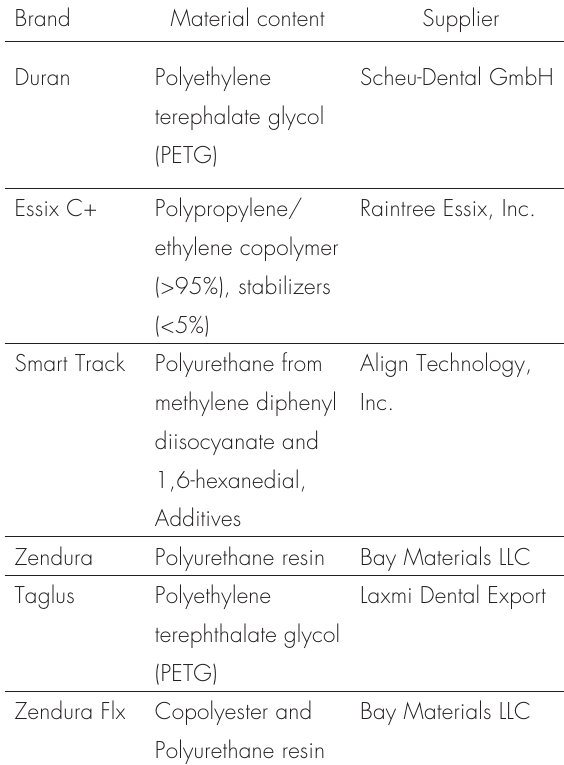
Table I. Clear aligner brands and their